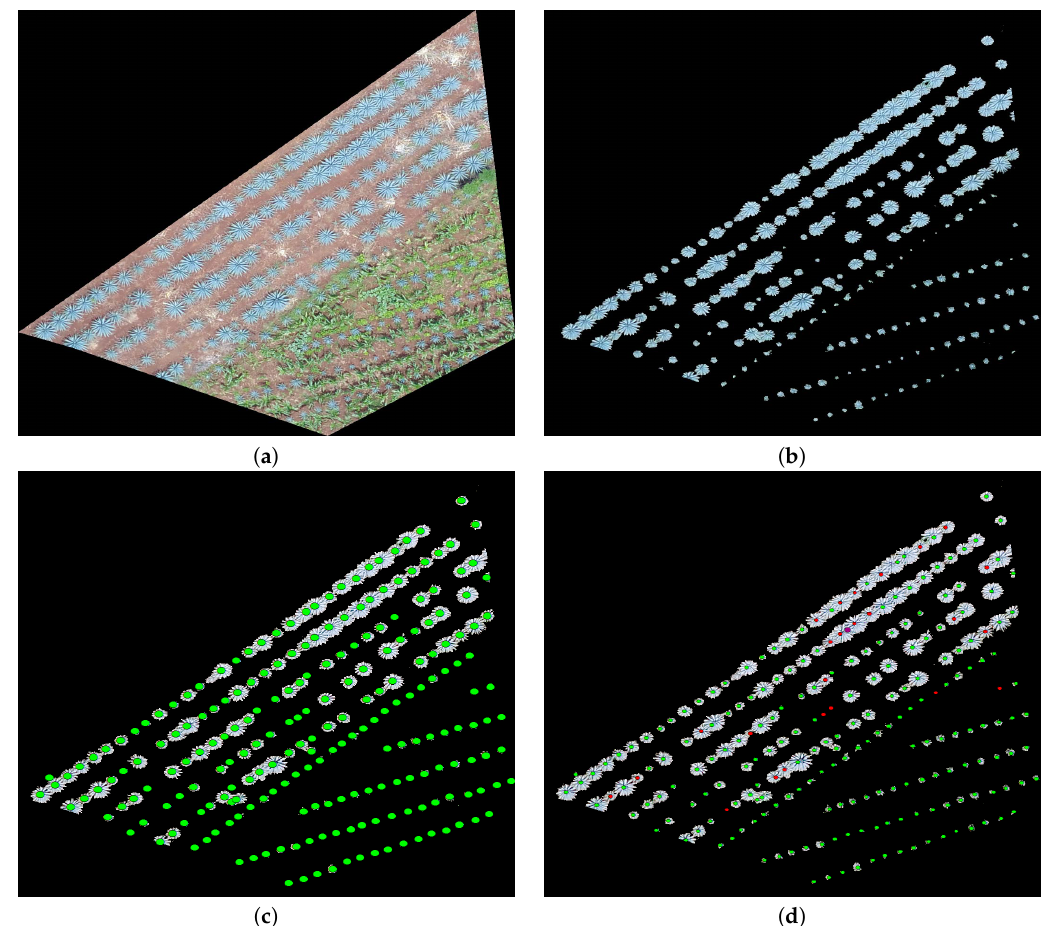
Figure 13. ( a ) A polygon in blue in Field 1 ( Figure 2), ( b ) an extracted agave layer by means of the methodology in [2], ( c ) agave plants counted by an expert (ground truth), and ( d ) agave plants detected by the proposal: those not detected appear in red